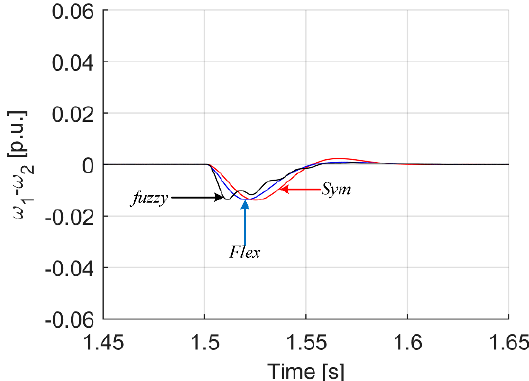
Figure 10. Transients of difference between motor and reference speed under torque load change.